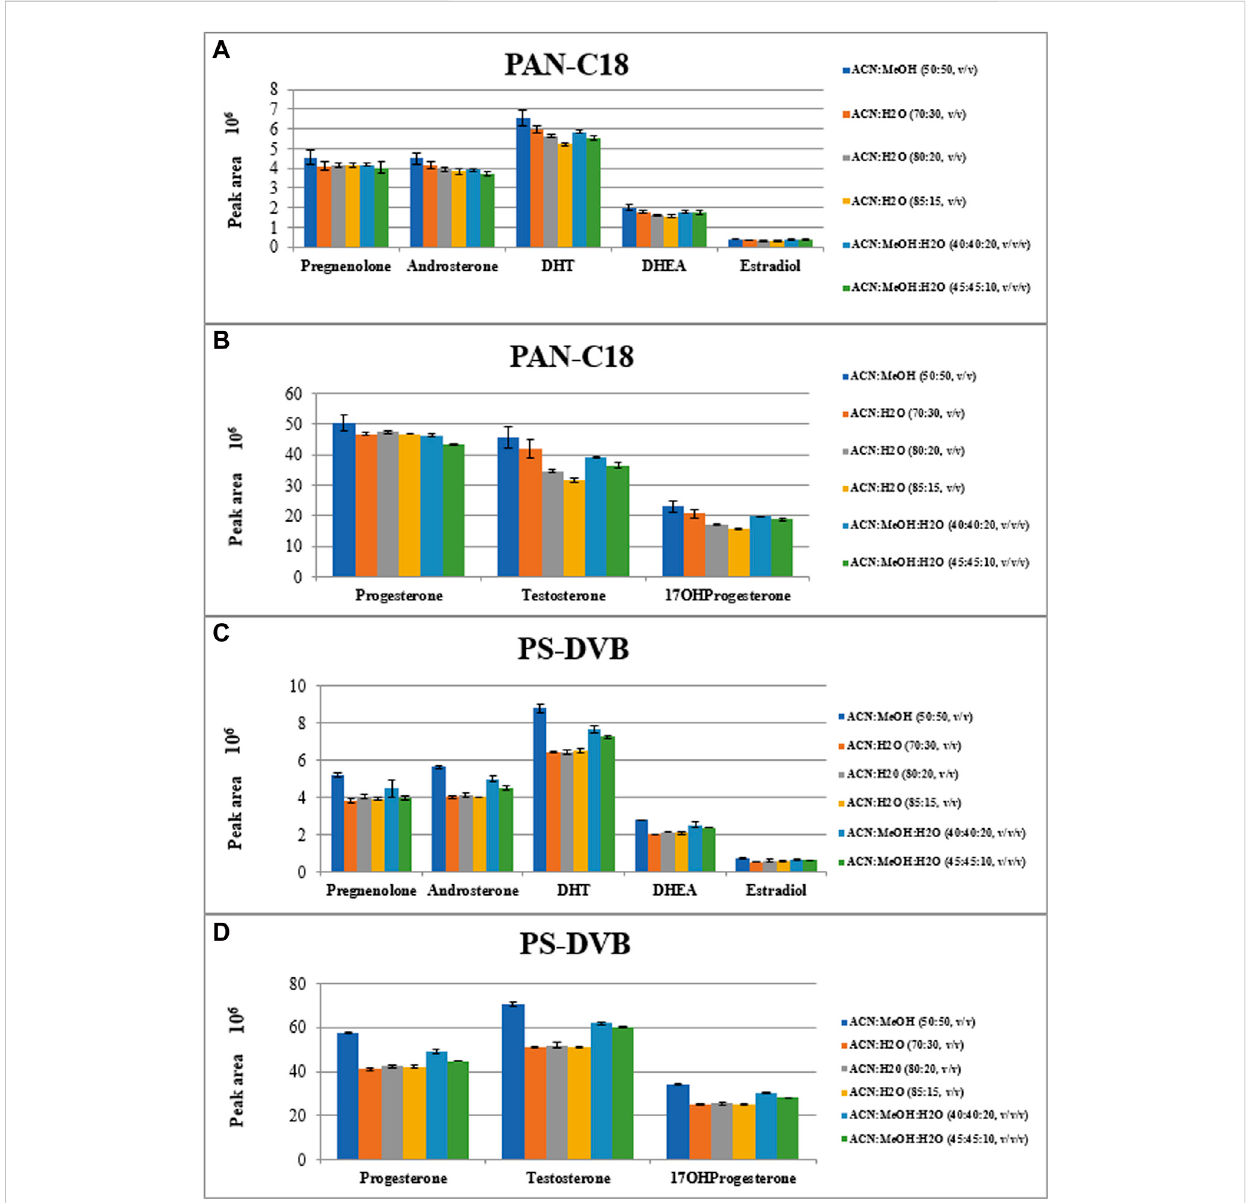
FIGURE 3 The peak areas of extracted steroid hormones depending on type of extraction sorbent (A, B) : PAN-C18; (C, D) : PS-DVB) and type of desorption mixtures.